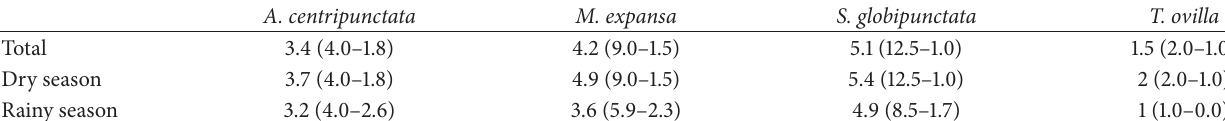
Table 1: Mean intensity of anoplocephalids among sheep during dry and rainy seasons.